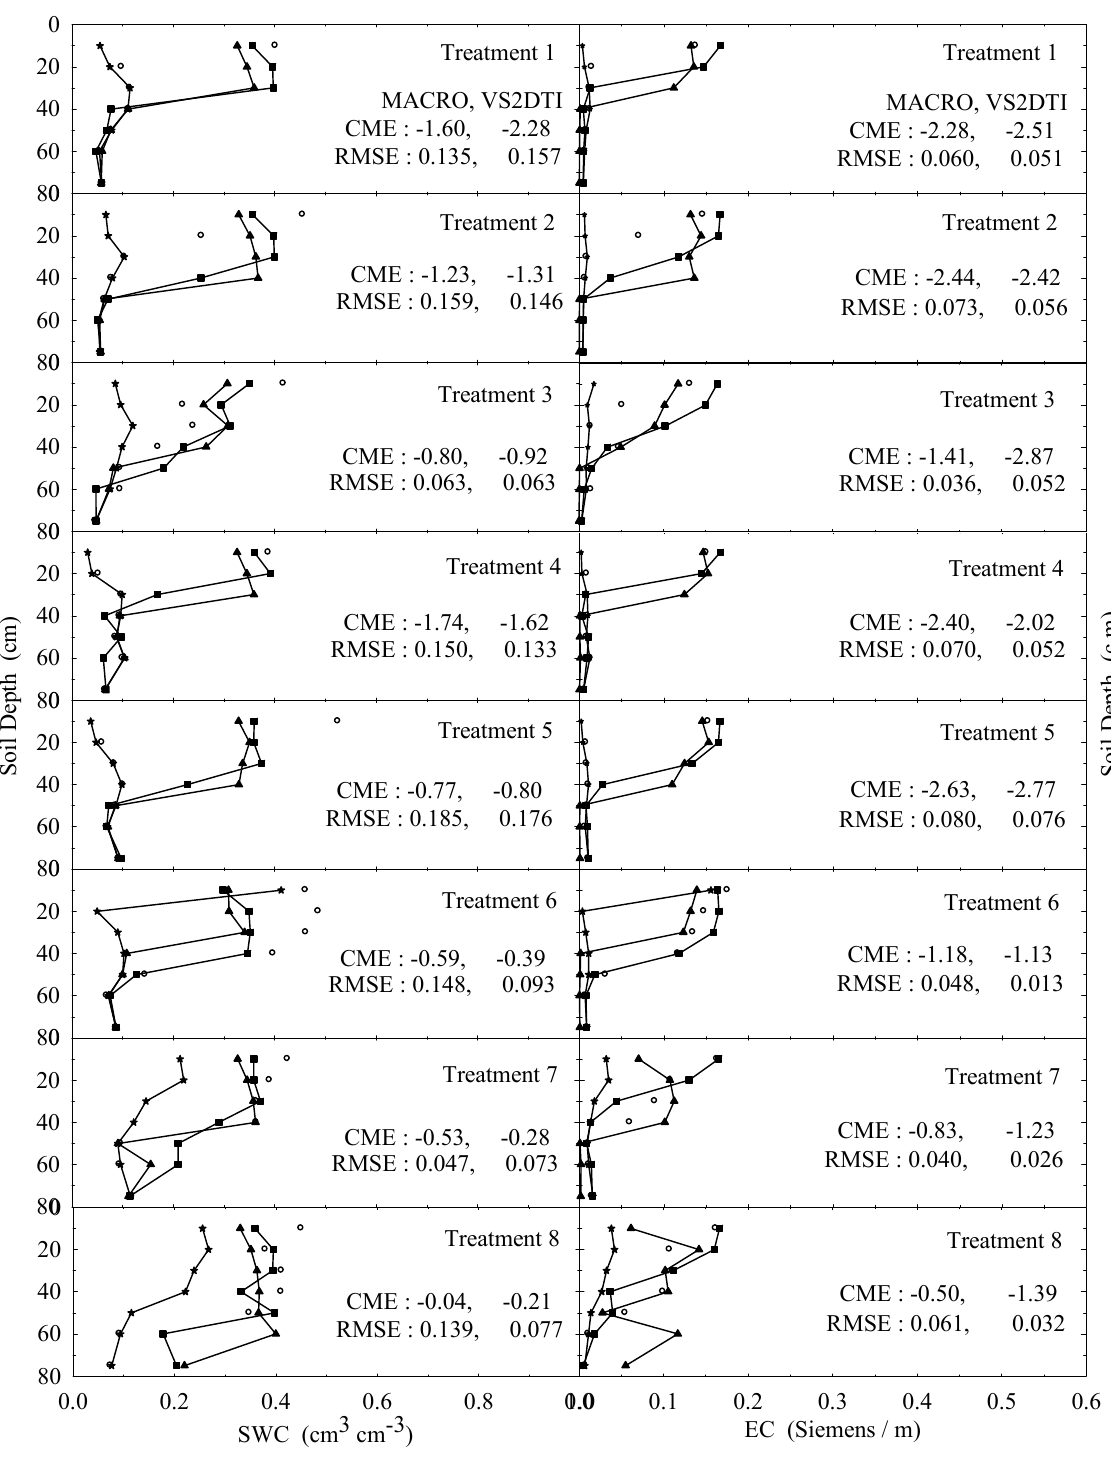
Figure 5. The variation of soil water content (SWC) and electrical conductivity (EC) with depth at 3 h of the experiment in the 8 treatments. The initial, measured, and model (MACRO and VS2DTI) values are exhibited by symbols ★ , ○ , ▲ , and ■ , respectively. CME and RMSE are the coeficient of model efficiency and the root mean square error,